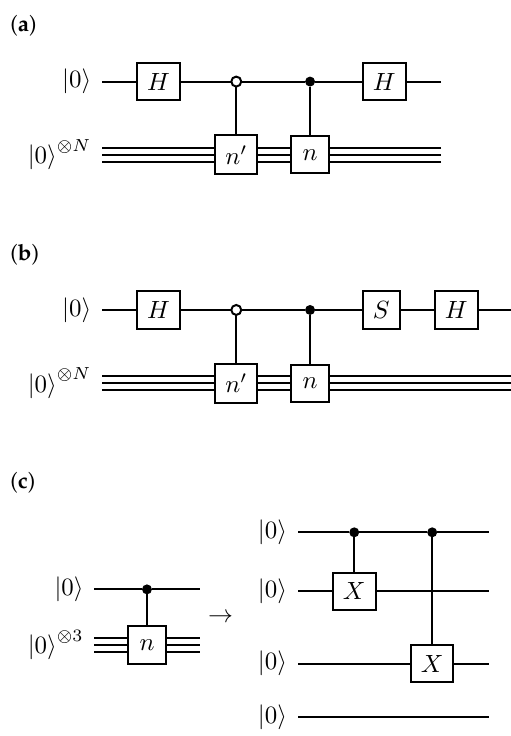
Figure 1. Quantum circuits for measuring ( a ) the real and ( b ) imaginary parts of an off-diagonal ˆ H n (cid:48) n element . ( c ) A controlled- n gate represents a set of CNOT gates that prepares the qubits in (cid:104) | | (cid:105) n the state . An example of controlled- n for N = 3 and | (cid:105)